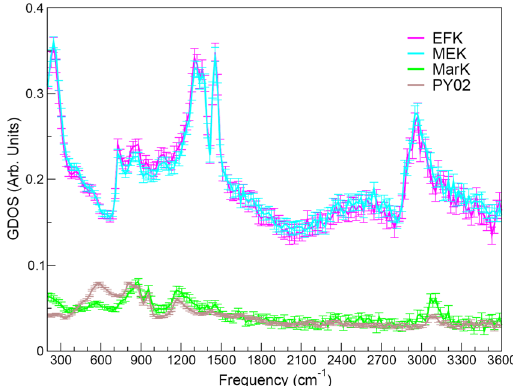
Figure 6. Generalized phonon densities of states (GDOS) of the EFK, MEK, MarK and PY02 samples from inelastic neutron scattering experiments (ref. 5). Error bars are computed from the square root of the neutron